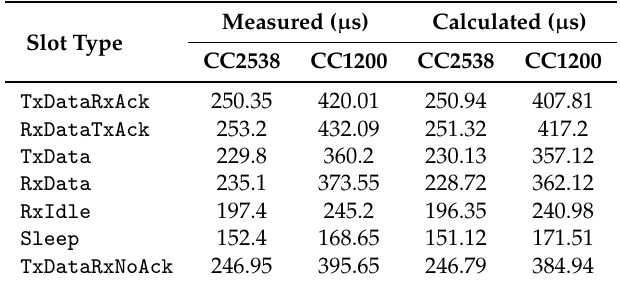
Table 16. Measured and calculated charge drawn for each slot